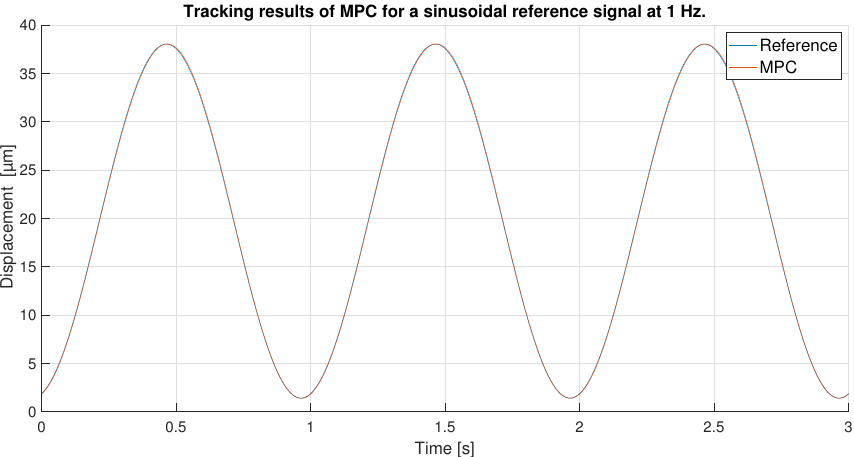
Figure 22. Tracking results of the MPC for a 1 Hz sinusoidal reference.